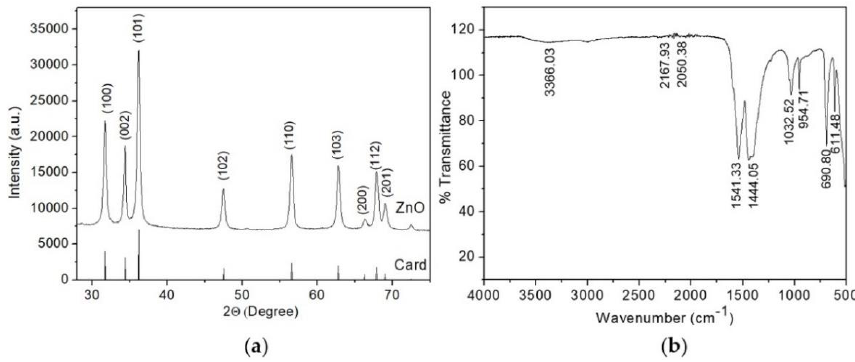
Figure 4. ( a ) X-ray diffraction pattern of ZnO layer; ( b ) FT-IR spectrum of ZnO